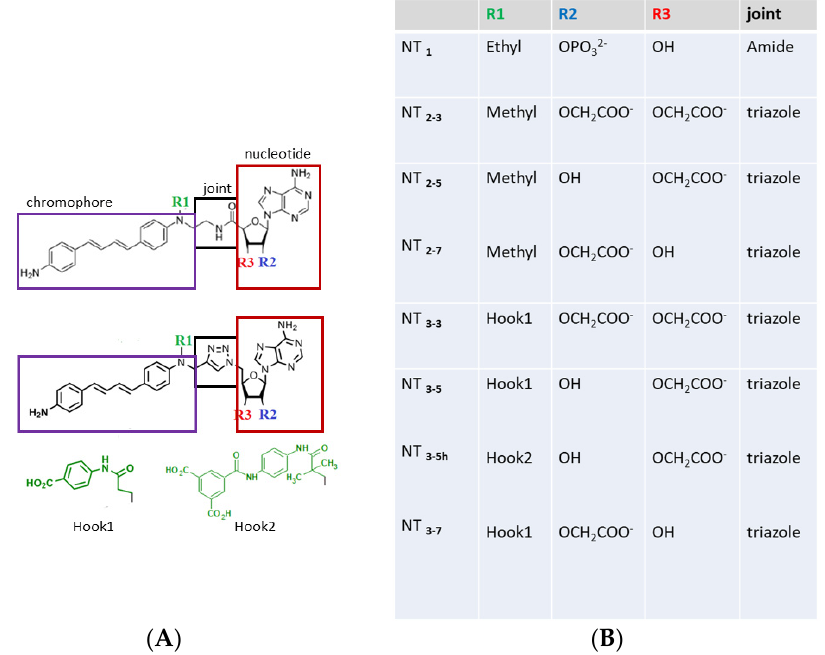
Figure 1. (A) Structures of the nanotrigger (NT) derivatives. In the prototype NT1 [16], the nucleotidic part boxed in red was kept identical to that of NADPH, as this moiety is responsible for interactions with conserved arginines found in the docking pocket in many NADPH- proteins [20,21]. The NADPH nicotinamide moiety was replaced by a photoactivable chromophore (purple box). An amide joint (black box) linked the nucleotidic and chromophore moieties. The R1 “hook” substituent of NT1 was an ethyl group. To further characterize how the charge carried by the ribose influenced binding to endothelial Nitric Oxide-Synthase (eNOS), the nucleotidic ribose was substituted by one or two carboxylate groups at either the 2’ or 3’ position or both, yielding NT2_7, NT2_5, and NT2_3, respectively [18,19]. In order to increase the a ffi nity of the nanotrigger for e / nNOS, a charged R1 “hook1” was added, which targets second hook2 was designed to target variable residues of eNOS. ( B ) List of the compounds described or designed in this